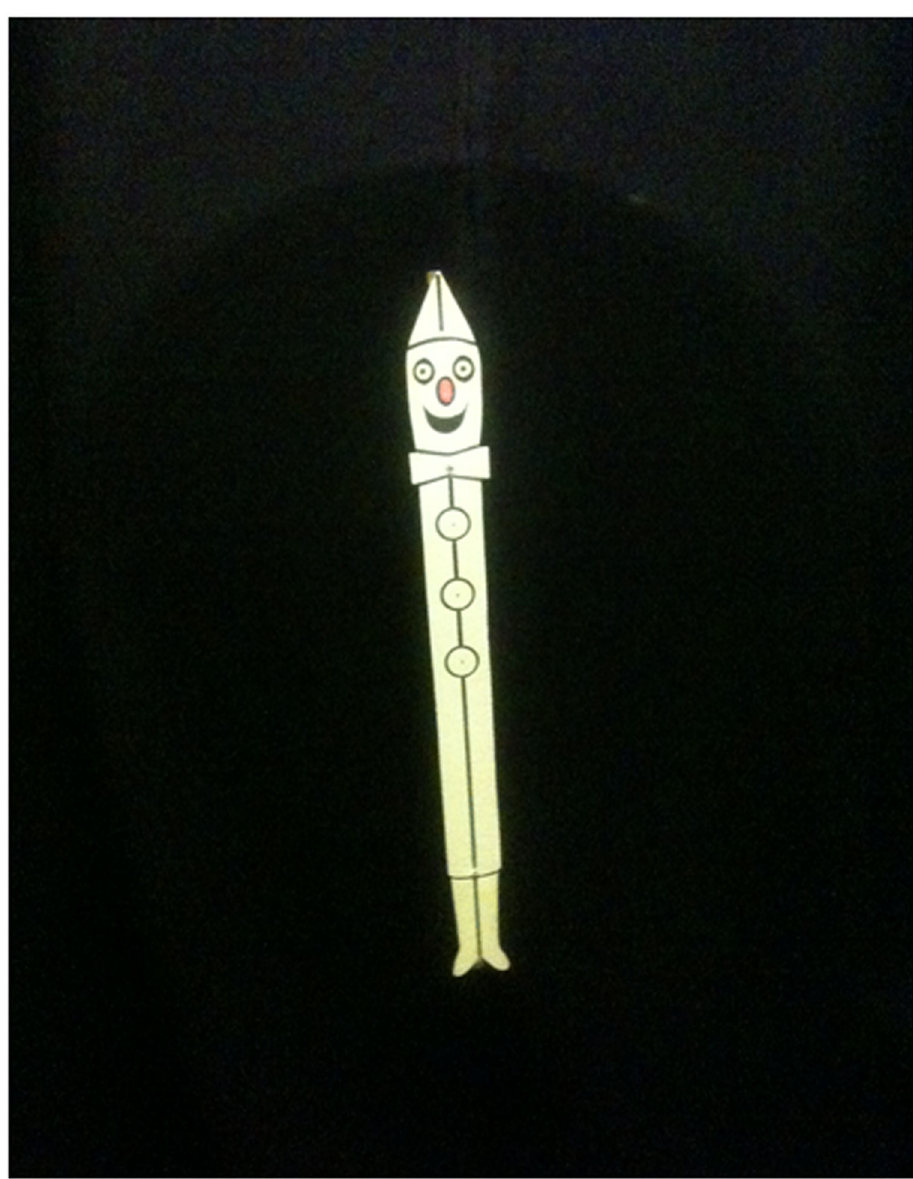
Figure 1. Subjective visual vertical equipment. The fluorescent cardboard looking like a clown used for the vertical perception. doi: